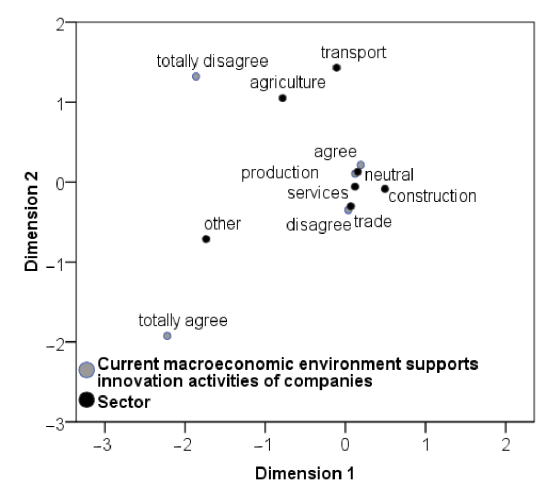
Figure 9. Correspondence analysis/the Slovak